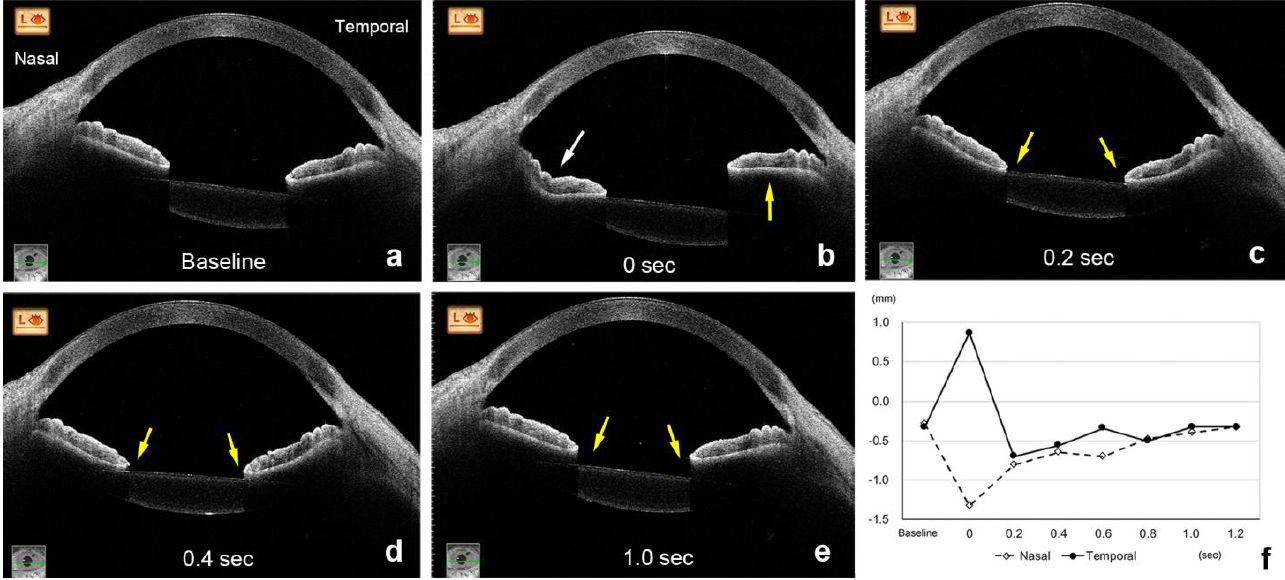
Figure 3. AS-OCT images of a 72-year-old woman in the ISF group. The nasal height of the iris (white arrow) decreases, and the temporal height (yellow arrow) increases at 0 s ( b ) from the baseline ( a ). The height of the nasal and temporal iris (yellow arrows) remains at the lower level at 0.2 s ( c ) and 0.4 s ( d ) and returns to the baseline level at 1.0 s ( e , f ). The amount of height change of the nasal iris from the baseline was significantly greater at 0 s in the ISF group ( − 0.68 ± 0.43 mm) than in the control group ( − 0.05 ± 0.09 mm, p < 0.001, Figures 2 and 4, Video S2). However, the amount of height change of the nasal iris was not significantly different between these 2 groups at 0.2 s ( p = 0.154), 0.4 s ( p =